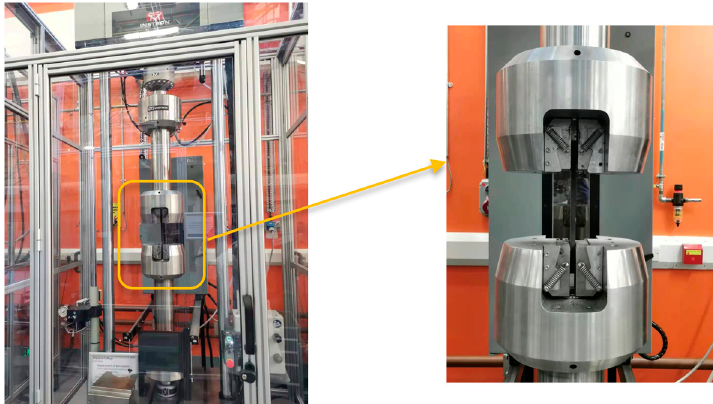
Figure 4. Schematic of Instron Hydraulic 250 kN test machine. Table 2. Fatigue test plan.